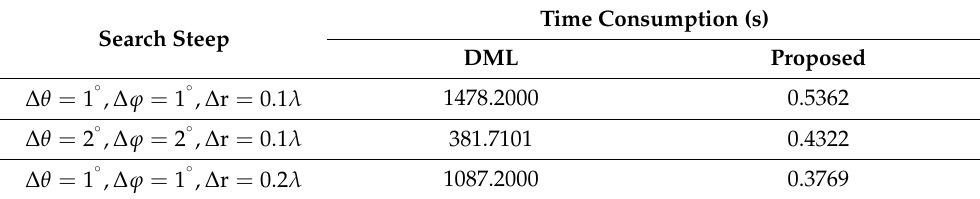
Table 2. Run-time of the two algorithms. Table 2. Run ‐ time of the two algorithms. Search